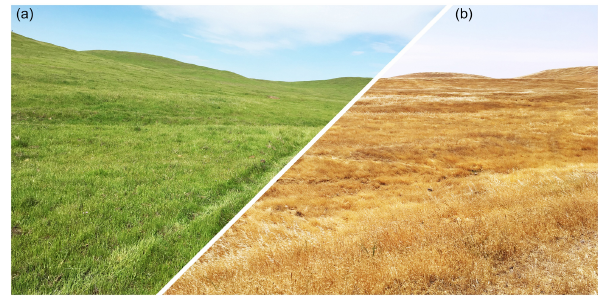
Figure 4. Typical scene of the study area in April (a) and June (b)